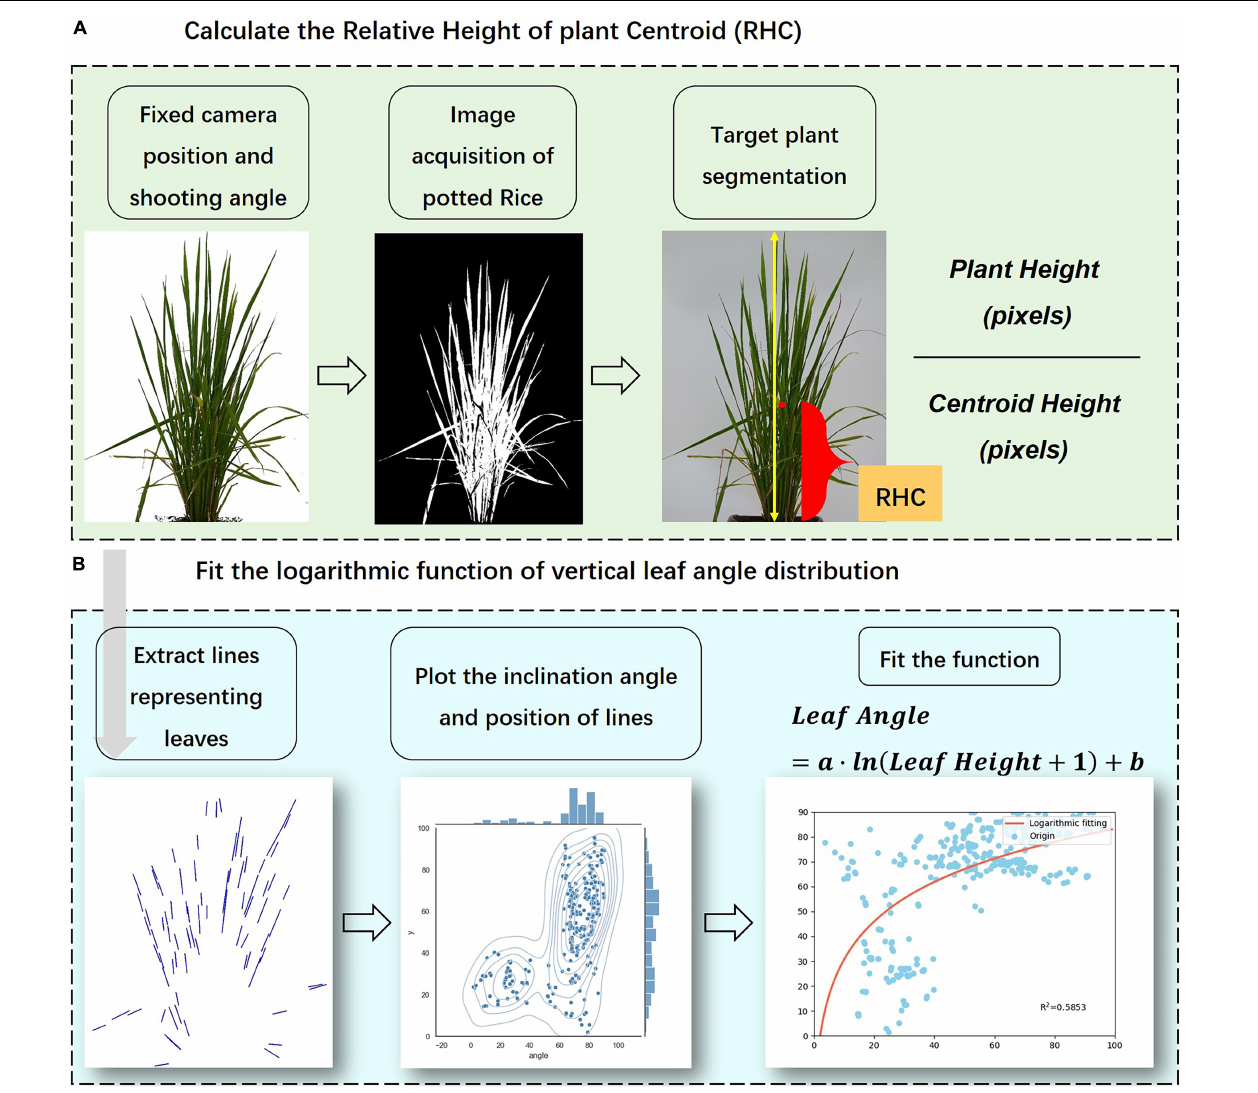
FIGURE 3 | Calculation of the visual indicators according to image processing results. (A) Calculation of RHC , (B) Fitting of vertical distribution